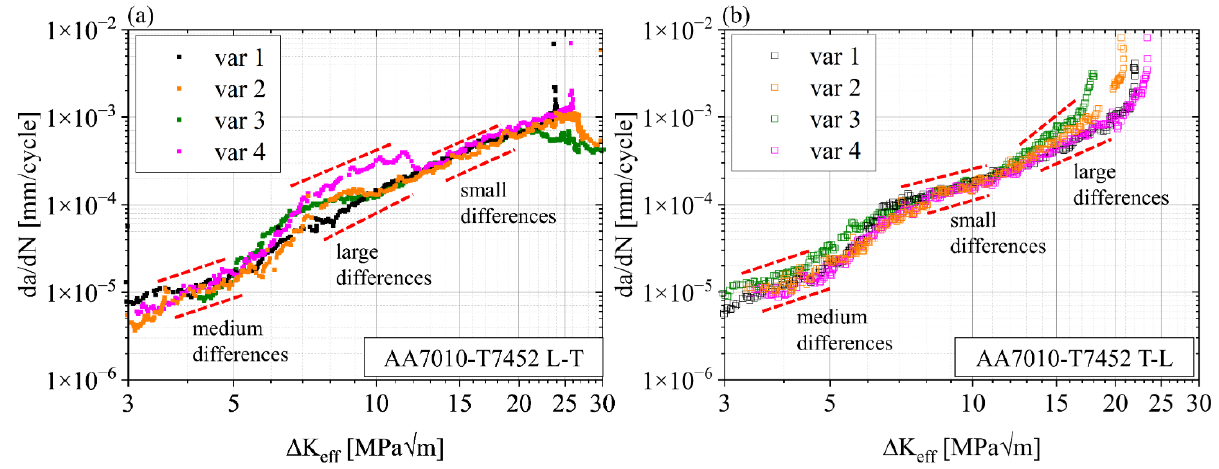
Figure 8. ∆ K eff fatigue crack propagation curves of AA7010-T7452 in four open-die forged conditions for ( a ) L-T orientation and ( b ) T-L orientation.